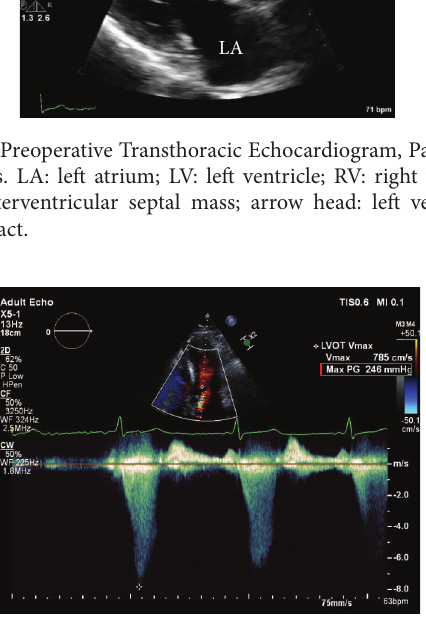
Figure 2: Preoperative Transthoracic Echocardiogram demonstrat- ing left ventricular outflow tract pressure gradient of 246 mmHg with Valsalva.